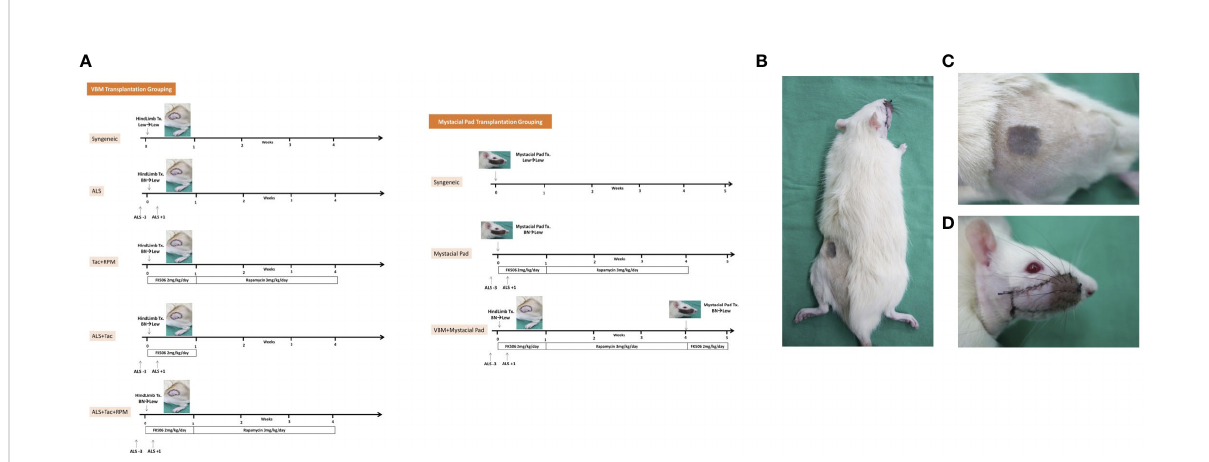
FIGURE 1 Sequential allotransplantation model of vascularized bone marrow and mystacial pad. (A) Grouping and timeline of immunosuppression. (B) Macroscopic photograph of a recipient rat with sequential transplantation. (C) Vascularized bone marrow allograft on 37 days post vascularized bone marrow transplantation. (D) Mystacial pad allograft on 7 days post mystacial pad